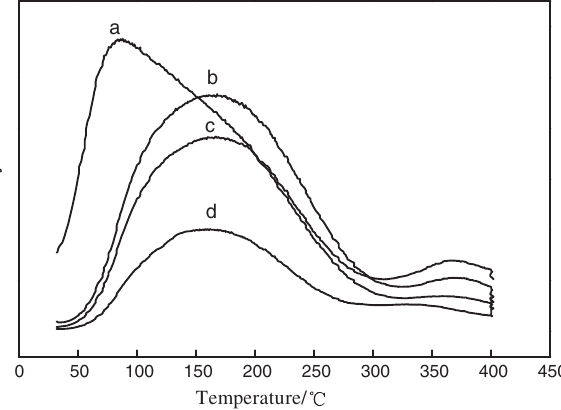
Figure 5: (a) Thermal luminescence spectrum of 70ZnO – 10P 2 O 5 – 20SiO 2 – 5Tb 3 þ and (b, c, d) thermal luminescence spectrum of